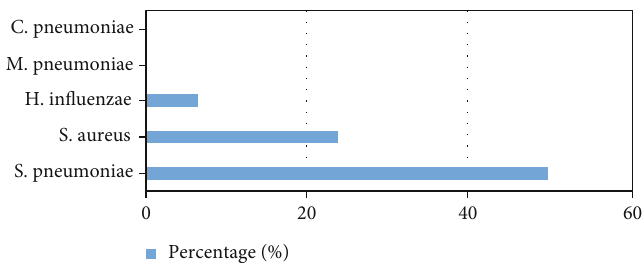
Figure 2: Distribution of bacteria in NPS of children with RSV (+) pneumonia. Table 2: Predictors of RSV (+)